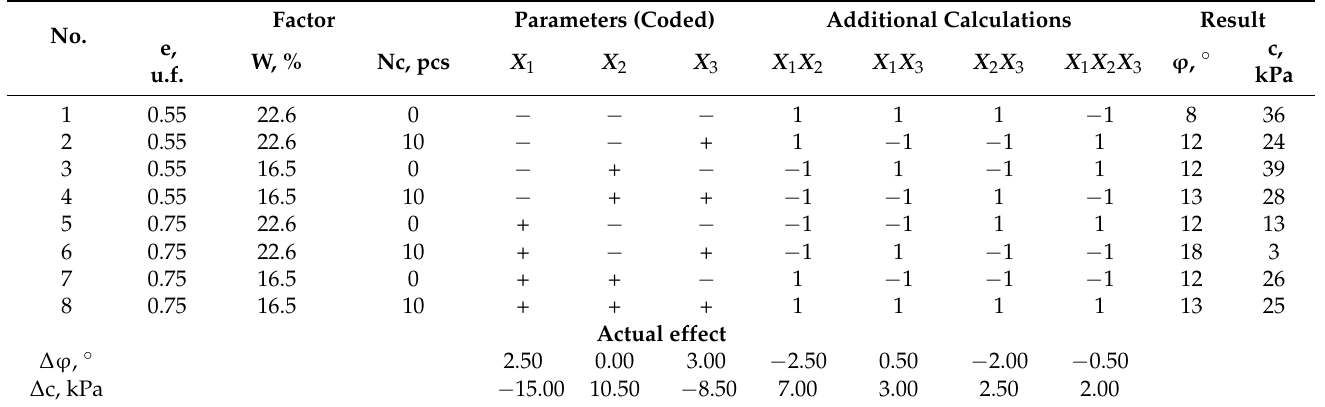
Table 3. Calculation of the actual effect of factors and their interactions.